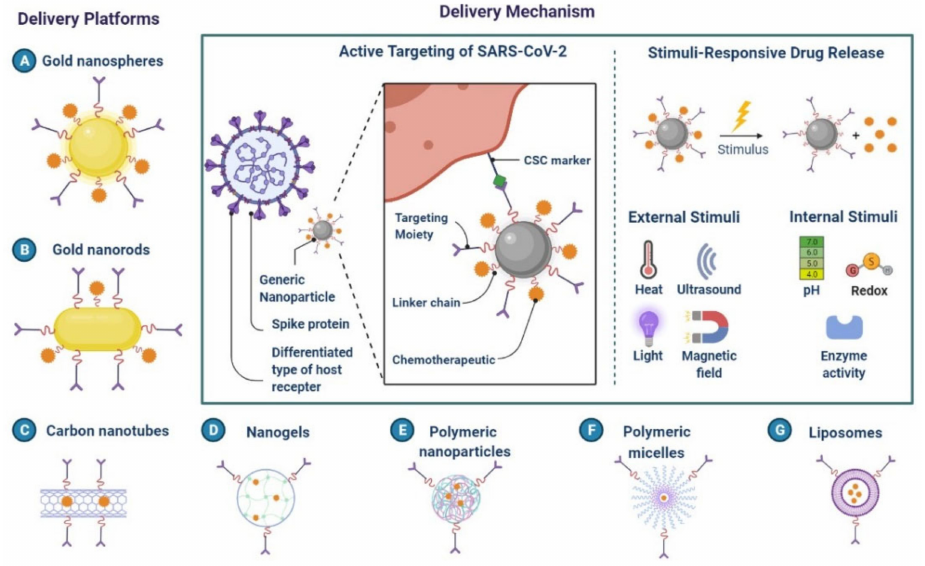
Figure 25. Nanoparticle-Mediated Targeted Drug Delivery.